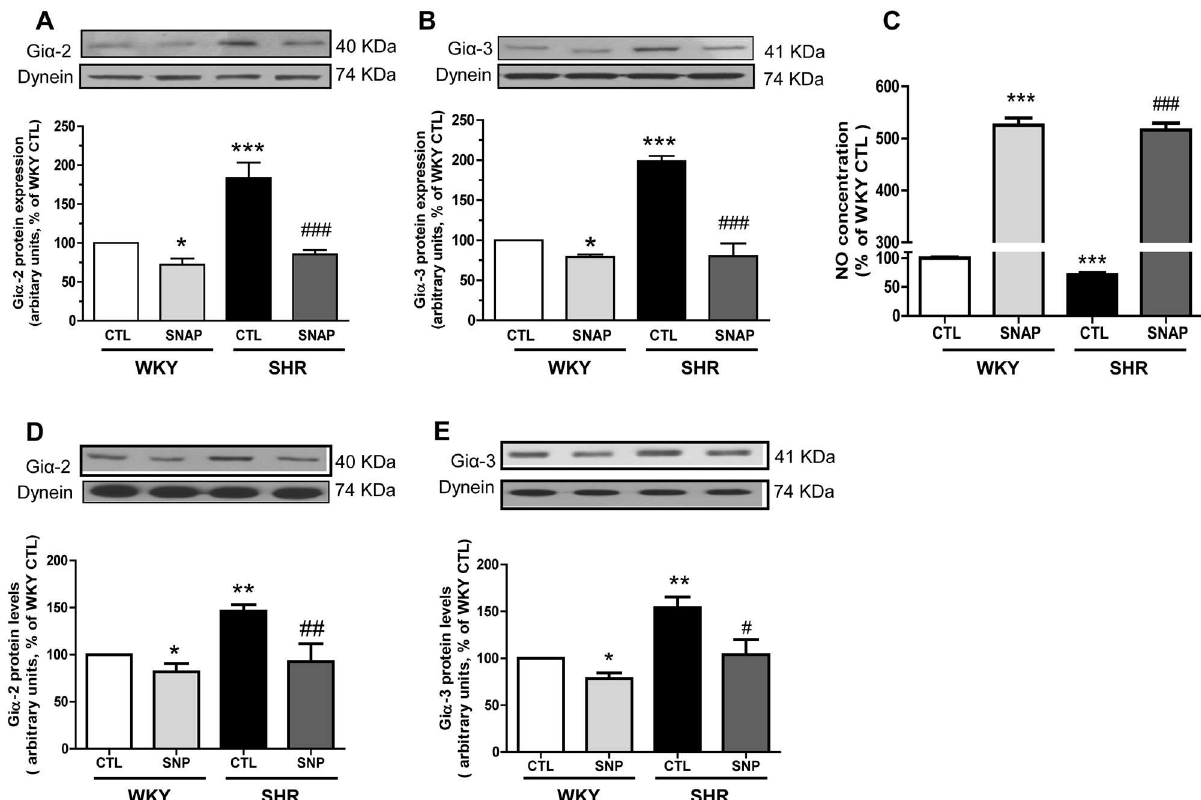
Fig 1. (A and B) Effect of S-nitroso-N-acetylpenicillamine (SNAP) and sodium nitroprusside (SNP) (D and E) on the Gi α protein expression in the aortic vascularsmooth muscle cells (VSMC) from 12-week old spontaneously hypertensive rats (SHRs) and age-matched Wistar-Kyoto (WKY) rats. ConfluentVSMCs were starved 24 h and incubatedin the absence (control) or presenceof SNAP (100 μ M) (A and B) or SNP (100 μ M) (D and E) for 24 h. The cell lysates were preparedand subjectedto Western blot analysisusing specific antibodiesagainstGi α -2(A and D) and Gi α -3 (B and E) or dynein as loadingcontrol, (upper panel)as describedin the Materialsand methods. (C): Effect of SNAP treatment on NO production in aortic vascularsmooth muscle cells (VSMC) from 12-weekold spontaneously hypertensive rats (SHRs) and age-matched Wistar-Kyoto (WKY) rats. ConfluentVSMC from SHR and WKY rats with or without SNAP treatment were incubatedat 37˚C for 1 h with fluorescent probes diaminofluorescein-2 diacetate(DAF-2DA) and levels of NO were determined as describedin Materials and Methods. Results are expressedas percentages of WKY control group (taken as 100%). Values are mean ± SD of 4 separate experiments using different cell populations from different animals. * P < 0.05, ** P < 0.01 *** P < 0.001 vs WKY control (CTL); # P < 0.05, ## P < 0.01, ### P < 0.001vs SHR